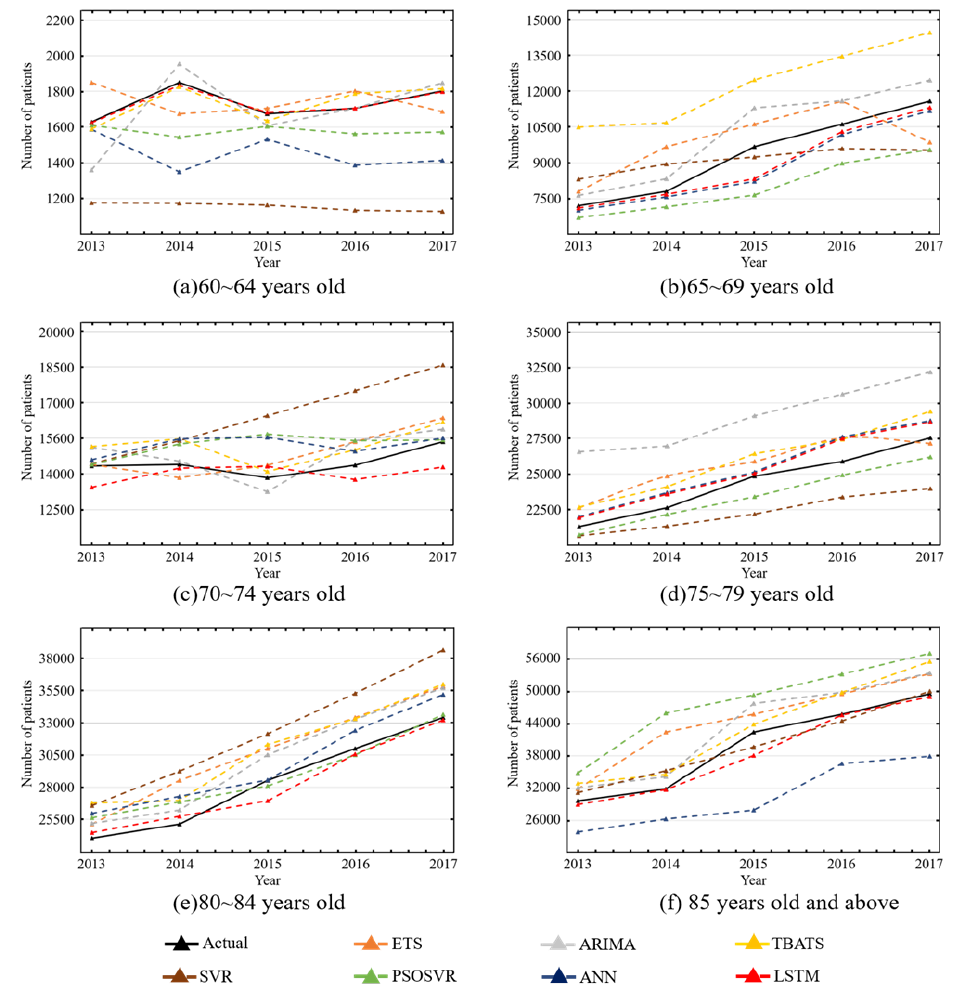
Figure 4. Prediction results of the number of male dementia patients with different models at dif- ferent age from 2013 to 2017. ( a ) 60~64 years old; ( b ) 65~69 years old; ( c ) 70~74 years old; ( d ) 75~79 years old; ( e ) 80~84 years old; and ( f ) 85years old and above.